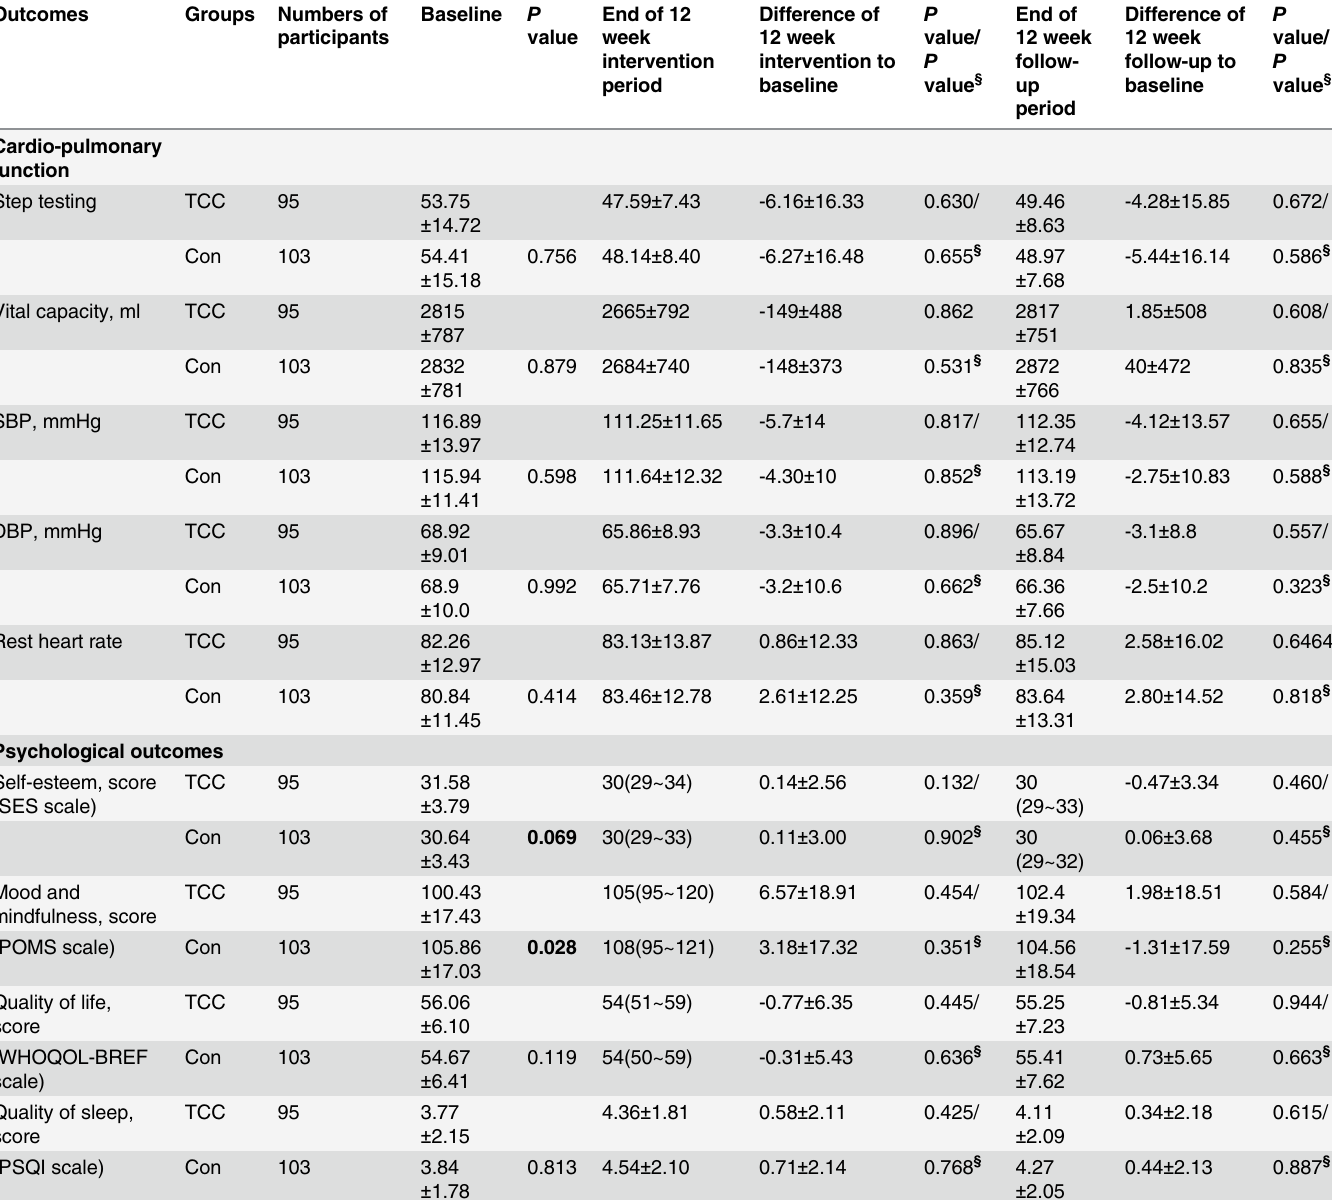
Table 4. Secondary outcomes on physical and psychological health(Mean ± SD/ Median (Inter-quartile range). Outcomes Groups Numbers of